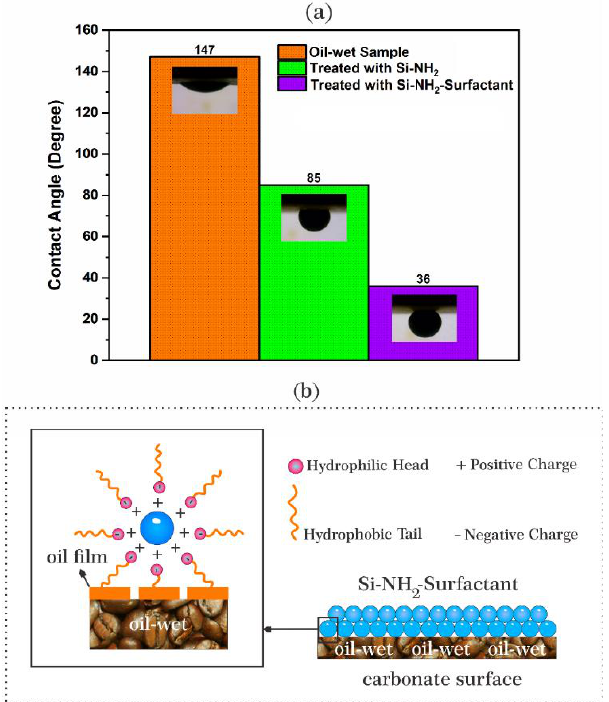
Figure 12. ( a ) The wetting angle ( θ ) values for three carbonate rock samples and ( b ) the representa- tional image of wettability alteration by Si-NH 2 -Surfactant nanoparticles.